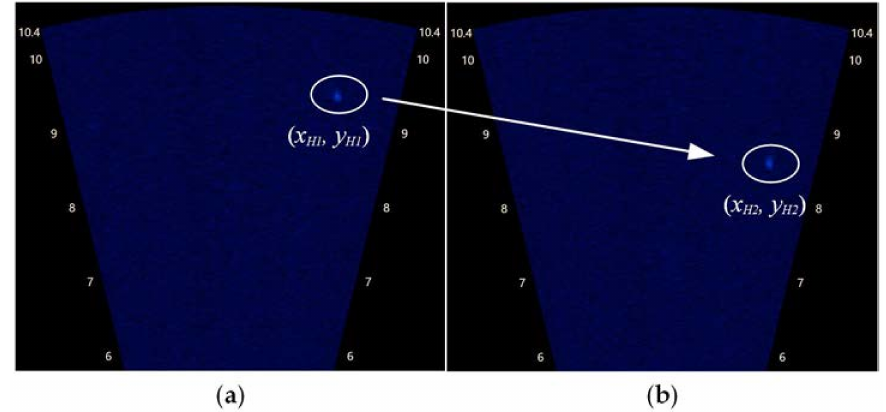
Figure 8. The sonar images corresponding to the data of condition No. 2 in Table 1. ( a ) Image acquired at time 1; ( b ) image acquired at time